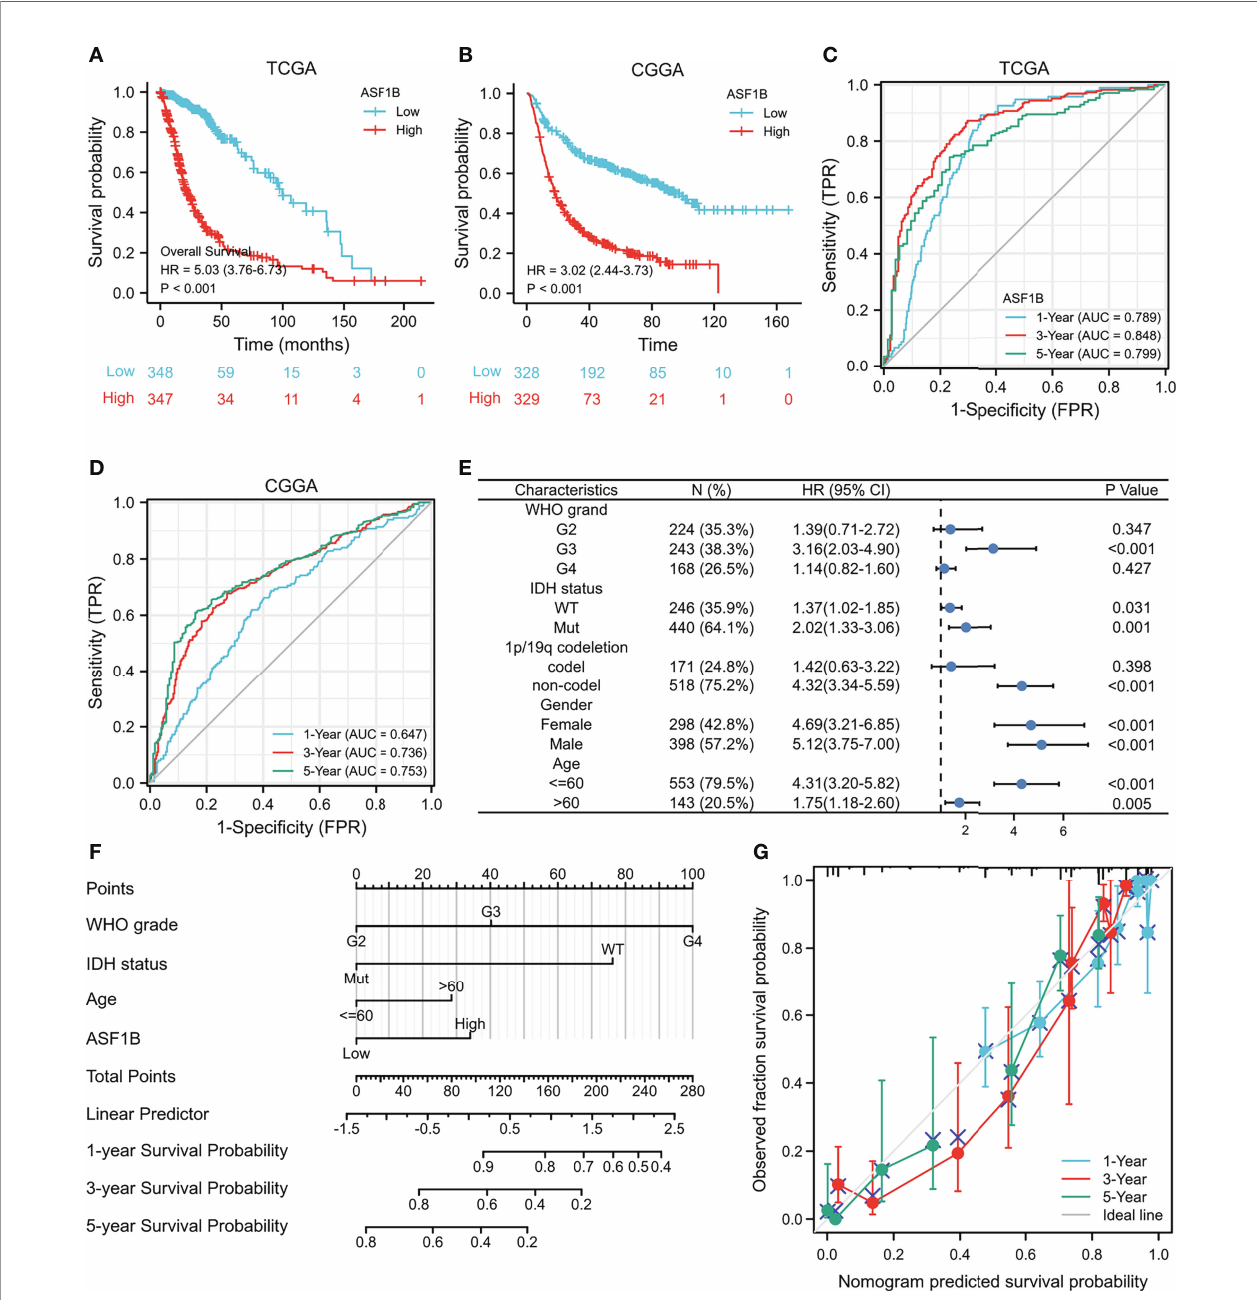
FIGURE 4 | High expression of ASF1B indicates poor survival in patients with gliomas. (A) Kaplan – Meier survival curve analysis of overall survival (OS) showed that high ASF1B expression correlated to poor prognosis of gliomas patients from the TCGA database. (B) Kaplan – Meier survival curve analysis of OS showed that high ASF1B expression correlated to poor prognosis of glioma patients from the CGGA database. (C) Time-dependent ROC analysis of ASF1B expression in glioma patients from the TCGA database. (D) Time-dependent ROC analysis of ASF1B expression in glioma patients from the CGGA database. (E) Prognosis of ASF1B expression in subgroups of clinical features from TCGA the database. (F) A nomogram that integrates ASF1B and other prognostic factors in gliomas from the TCGA database. (G) The calibration curve of the